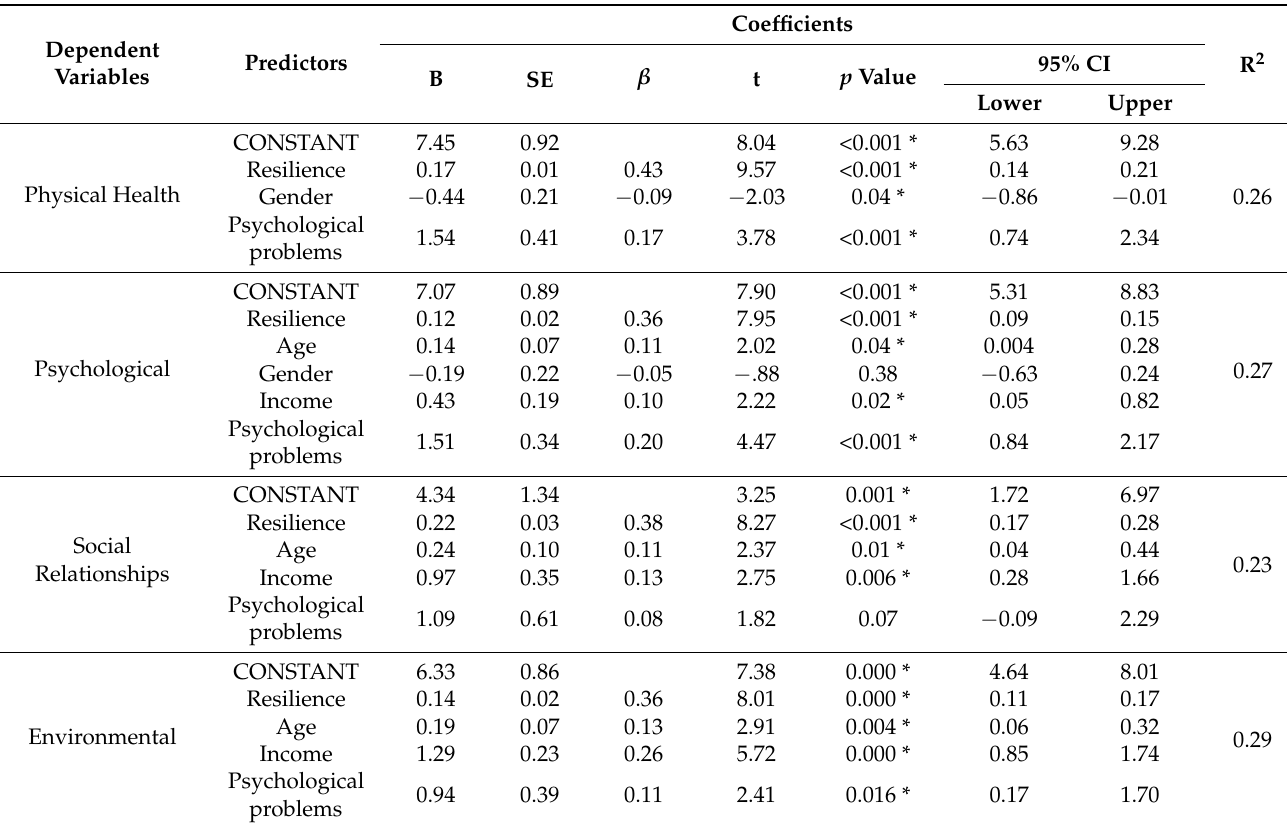
Table 8. Multiple linear regression models with the four domains of WHOQOL-BREF as dependent variables among study respondents (N =